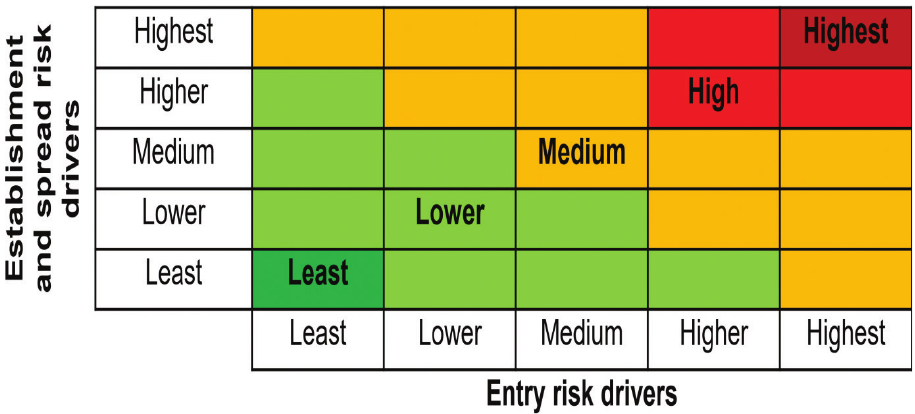
Figure 3. Martix for combining entry risk with establishment and spread risk to form an overall assess- ment of vulnerability to Xf invasion, based on Early et al. (2016). The diagram assembles five relative rank categories at each stage of invasion considered in our risk ranking